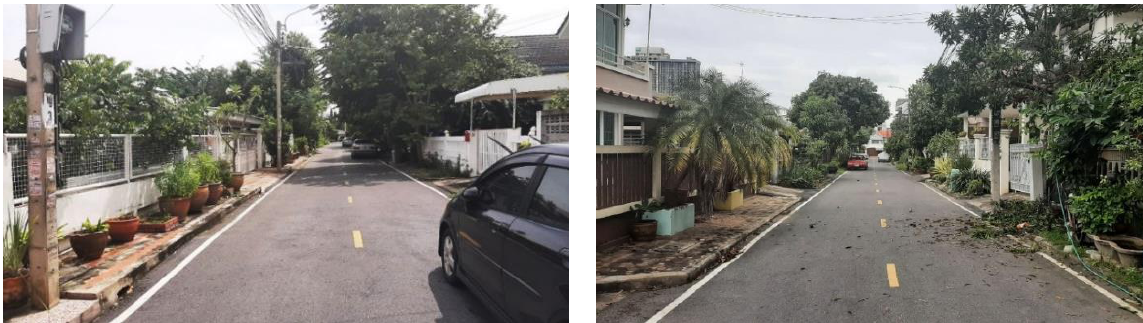
Figure 3. The experimental residential area.